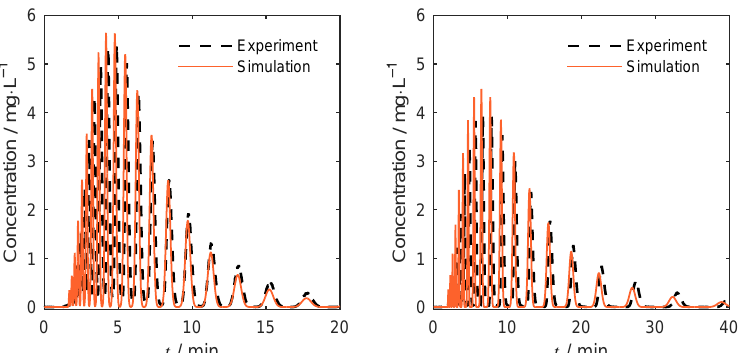
Figure 6. Validation of the process model for the preparative column at two different condi- tions. Symbols—experimental data, lines—simulated total outlet concentration, Σ i c out , i ( t ) , acc. to Equation (3). ( Left ) experiment at 20 ◦ C. ( Right ) experiment at 35 ◦ C. Other conditions: eluent 20 vol% ACN, sample 50 µ L of 5 g/L PEG 1000 in water. Simulation with averaged values for NTP of 3330 (20 ◦ C) and 4670 (35 ◦